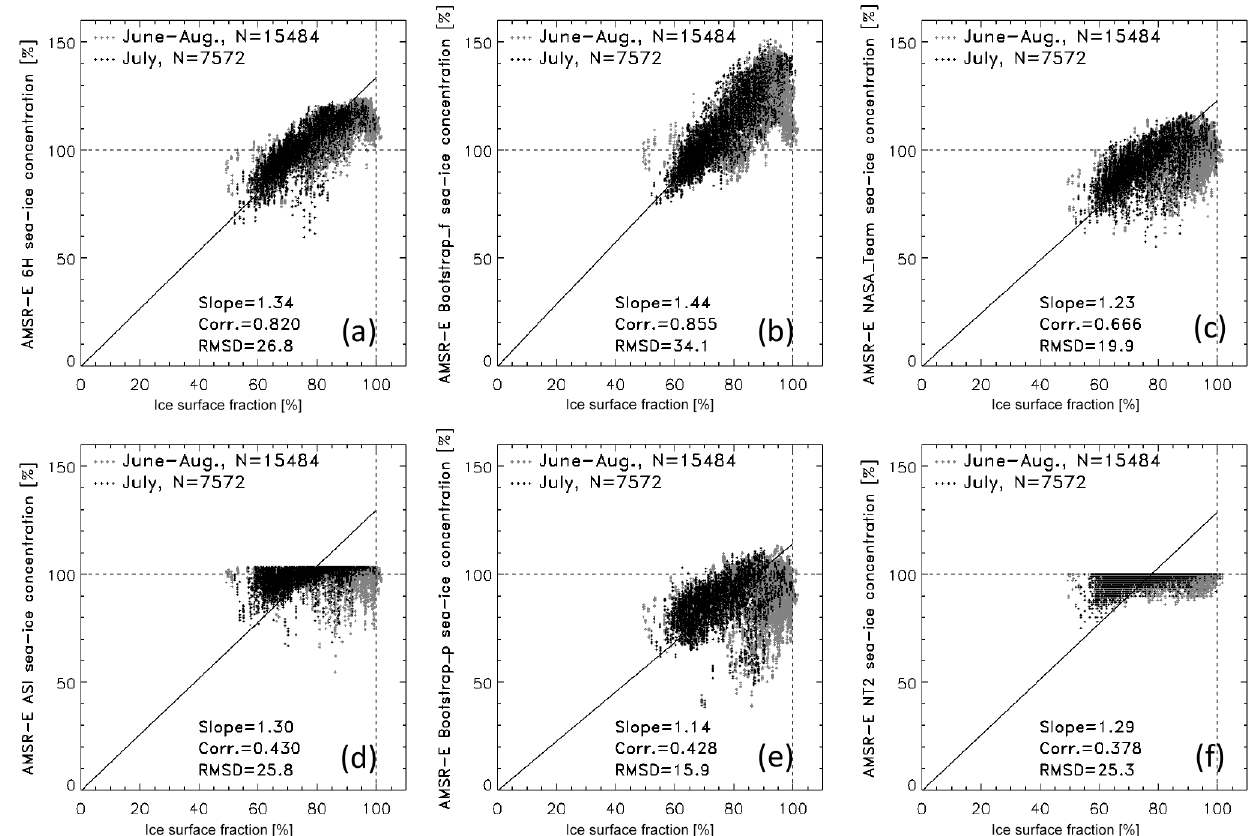
Figure 5. AMSR-E sea-ice concentration computed with six of the eight algorithms listed in Table 2 vs. MODIS ice-surface fraction for all grid cells with MODIS sea-ice concentration > 90% and cloud fraction < 5%. Gray and black symbols denote data from the entire period and July only, respectively. The black line denotes a linear regression of the sea-ice concentrations of July forced through ( 0 , 0 ) with the slope as given in the each image. The linear correlation coefficient and root mean square difference for sea-ice concentrations of July are denoted by “Corr.” and “RMSD”. Slope, Corr, and RMSD for June, July (this figure), and August are summarized in Tables